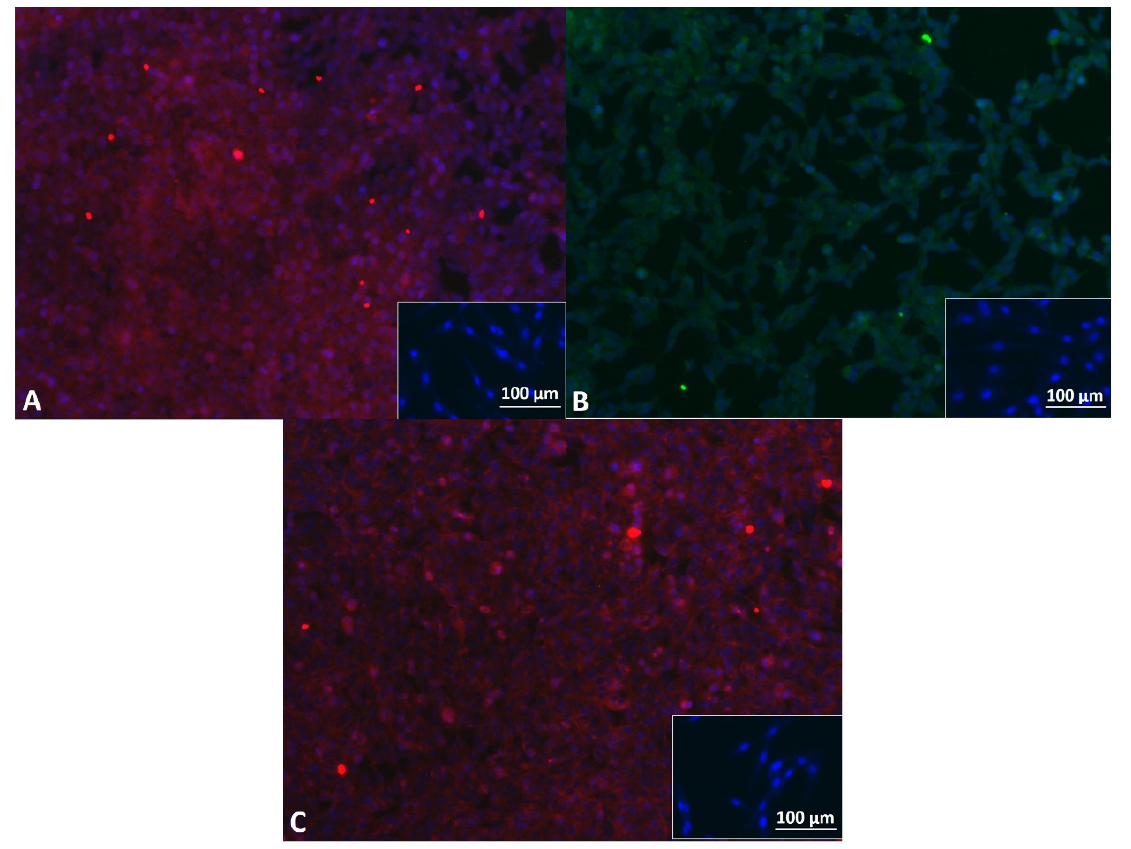
Figure 3. Fluorescence microscopy of human Schwann cells (SC) in P5. Cells were positive for glial fibrillary acidic protein (GFAP) (red) ( A ), S100 (green) ( B ), and p75 (red) ( C ). Inserts represent human Mbs (blue = DAPI) as negative controls. Scale bars 100 µm apply to inserts as well as to main images.